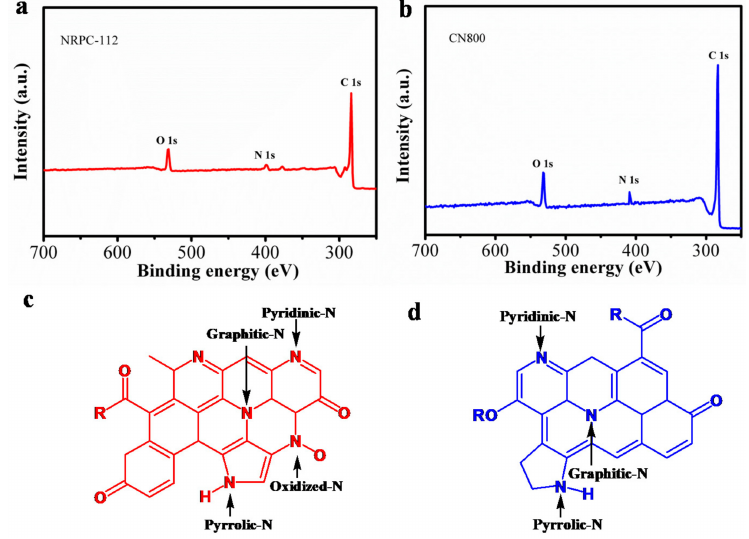
Figure 7. ( a ) XPS survey spectra of NRPC-112, ( b ) XPS survey spectra of CN800, ( c ) di ff erent of N and O in NRPC-112, ( d ) di ff erent of N and O in